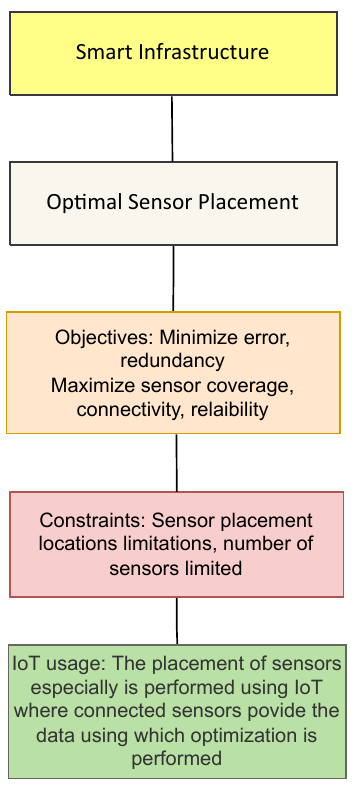
Figure 7. Optimization applications in Smart